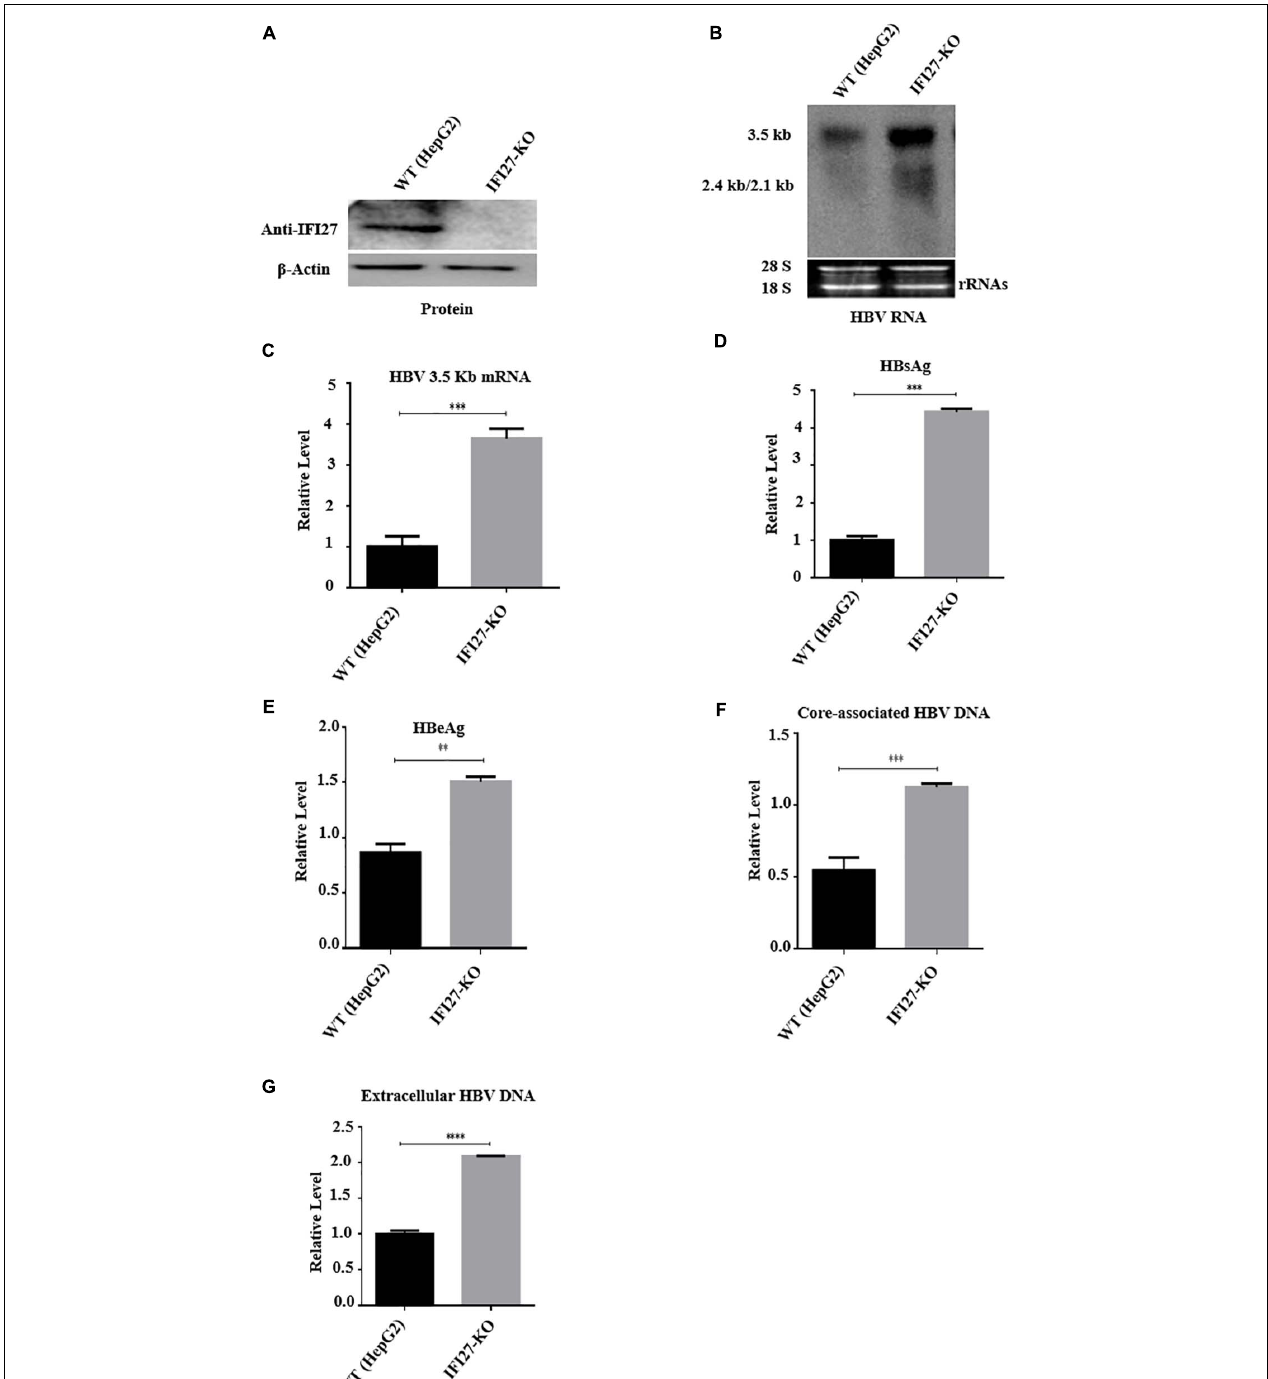
FIGURE 4 | IFI27 knockout (IFI27-KO) in HepG2 cells promotes HBV replication. (A–F) IFI27-deficient HepG2 cell line (HepG2 IFI27-KO) was generated by the CRISPR/Cas9 system using a guide RNA; the sequence is already shown in the methodology. HepG2 parent cells (wild-type) and the IFI27 knockout HepG2 cell line were transfected with HBV1.3 (800 ng) and pSV- β -gal (200 ng) and harvested after 48 h. (A) Western blot analysis was used to confirm IFI27 protein expression using an anti-IFI27 antibody and β -actin was used as a loading control. (B) Total RNA from HepG2 parent cell and IFI27-KO cells was extracted and detected with northern blotting. The 28S and 18S rRNAs were used as the internal control. (C) The HBV 3.2-kb mRNA was separately subjected to qRT-PCR. GAPDH was used as a loading control. (D,E) The secreted HBsAg (E) and HBeAg (F) proteins were analyzed using ELISA. (F,G) HepG2 parent cells and the IFI27 knockout HepG2 cell line were transfected with pHBV1.3 and harvested after 96 h. The HBV intracellular core-associated (F) and extracellular HBV DNA (G) from the supernatant were purified and subjected to qPCR. ** P ≤ 0.01, *** P ≤ 0.001, **** P ≤ 0.0001.